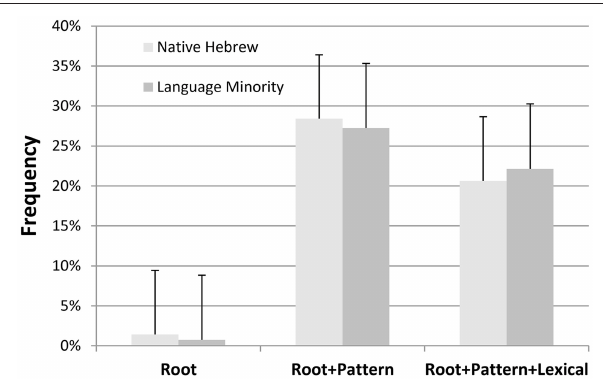
FIGURE 1 | Frequency of error types (SEM) in the real word sentence completion task, by